Question: Based on the figure, does the quantity rise or fall?
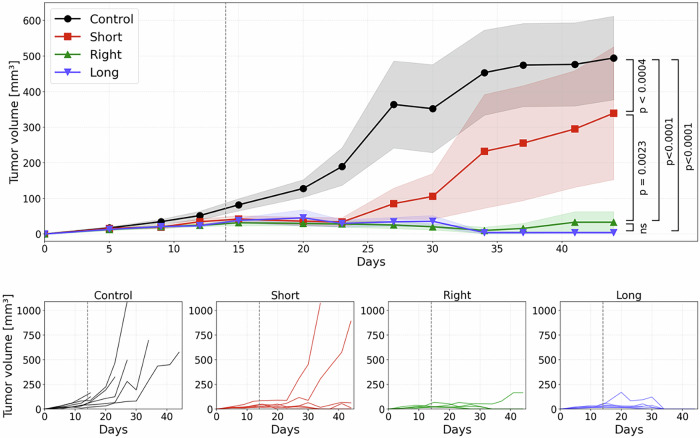
Answer: increasing